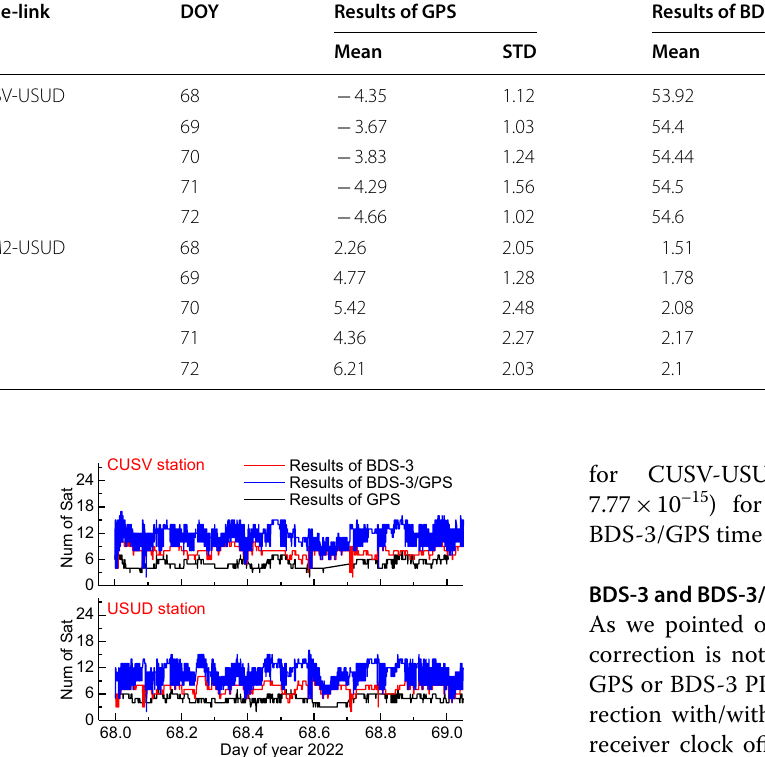
Table 2 Mean and STD values of the difference between the time transfer solutions calculated from BDS-3, GPS, and BDS-3/GPS PPP in Scheme 1 and the PPP time transfer with IGS final products (ns) Time‑link